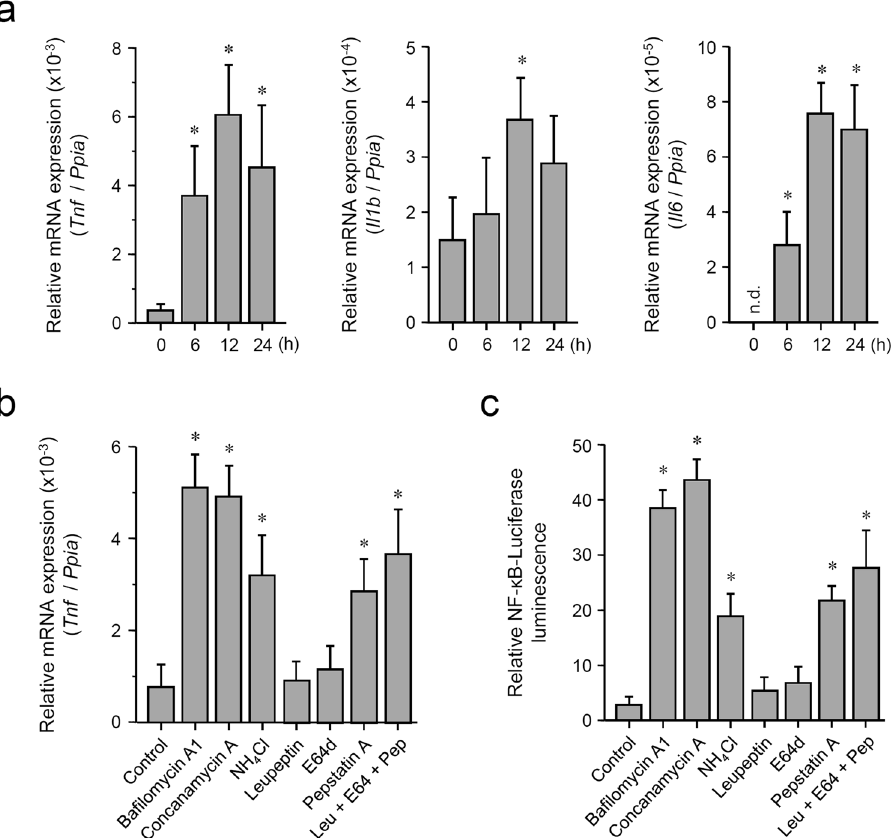
Figure 1. Pharmacological inhibition of lysosomes induces weak inflammatory signals in macrophages. ( a ) Induction of mRNA of inflammatory cytokines by BafA1 treatment. Mouse BMDMs were incubated with 100 nM BafA1 for the indicated periods, followed by RNA extraction. Relative expression levels of Tnf , Il1b , and Il6 were determined by qRT-PCR. Each value is expressed as the mean ± SD (n = 3); * p < 0.05 (versus 0 h), one-way ANOVA and Dunnett’s test for post-hoc comparisons ( μ c < μ i). n.d.: not detected (regarded as 0). ( b ) Treatment with the inhibitors of lysosomal functions or lysosomal proteases induces Tnf expression. Mouse BMDMs were incubated with 0.5% DMSO (control), 100 nM BafA1, 100 nM concanamycin A, 20 mM ammonium chloride, 50 μ M leupeptin, 50 μ M E-64-d, or 2 μ M pepstatin A for 12 h, followed by RNA extraction. Relative expression levels of Tnf were determined by qRT-PCR. Each value is expressed as mean ± SD (n = 3); * p < 0.05 (versus Control), one-way ANOVA and Dunnett’s test for post-hoc comparisons ( μ c < μ i). ( c ) Treatment with the inhibitors of lysosomal functions or lysosomal proteases activates NF- κ B-dependent transcriptional activity. The NF- κ B-driven luciferase reporter assay was performed in RAW264.7 cells. Cells were incubated with 0.5% DMSO (control), 100 nM BafA1, 100 nM concanamycin A, 20 mM ammonium chloride, 50 μ M leupeptin, 50 μ M E-64-d, or 2 μ M pepstatin A for 12 h. Relative NF- κ B activity was measured, and the data are expressed as mean ± SD (n = 3); * p < 0.05 (versus Control), one-way ANOVA and Dunnett’s test for post-hoc comparisons ( μ c < μ